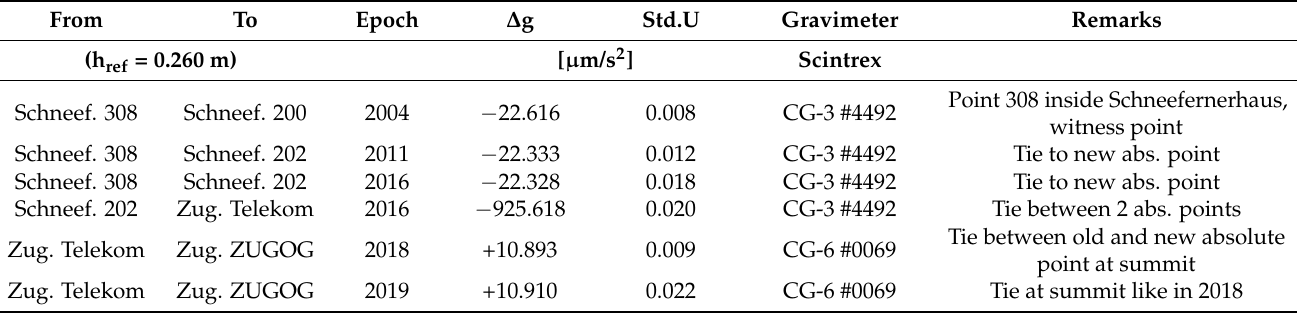
Table 3. Gravity differences ∆ g observed by relative gravimetry at Mt. Zugspitze. All ties are referred to a reference height of 0.260 m above floor level which is approx. the sensor-height of the CG-3 gravimeter (sensor-height CG-6 ≈ 0.22 m). Std.U is the standard uncertainty calculated in a least squares adjustment as the standard deviation of the resulting gravity